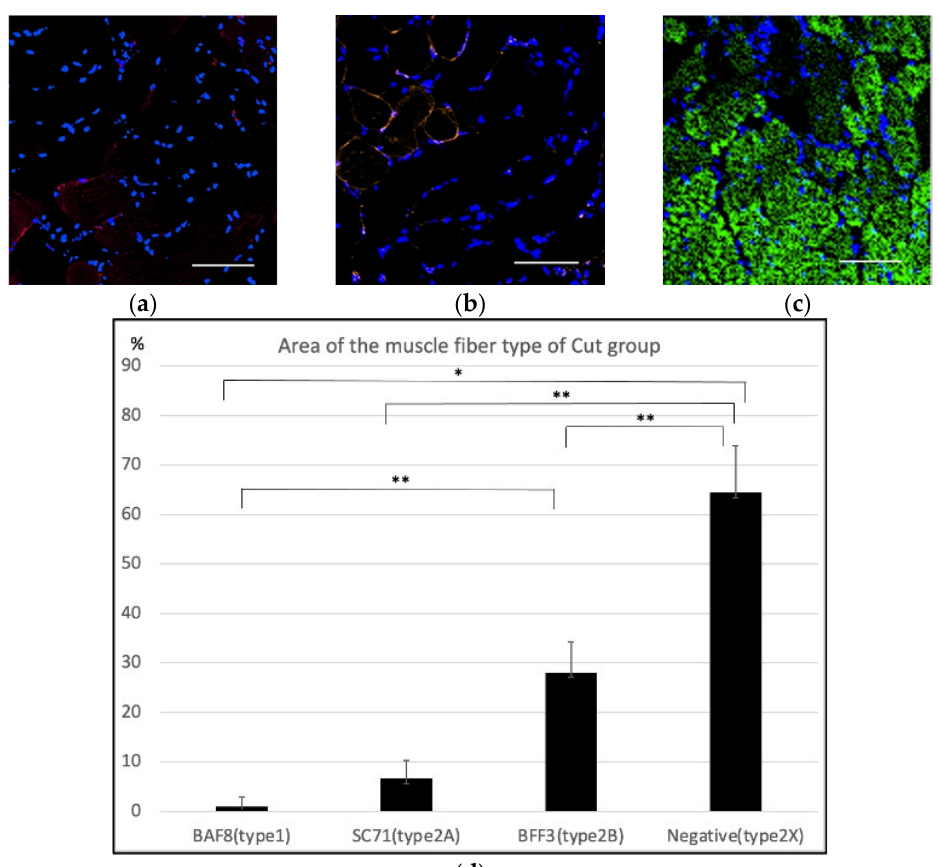
Figure 5. Immunohistochemistry of the masseter muscle in the cut group. ( a ) Anti-BAF8 (red) staining seemed to be almost negative. ( b ) Anti-SC71 (orange) staining showed a slightly positive area. ( c ) Some areas were negative for BAF8, SC71, and BFF3. ( d ) Anti-BAF8-, anti-AC71-, and anti-BFF3-positive areas and the negative area for all antibodies were analyzed with four specimens. The average percentage area of type 1, type 2A, type 2B and the estimated type 2X fibers was 0.92 ± 0.87%, 6.67 ± 6.65%, 27.99 ± 10.80%, and 64.42 ± 7.68%, respectively ( n = 4 for each group, * p < 0.01, ** p < 0.05, one-way ANOVA).